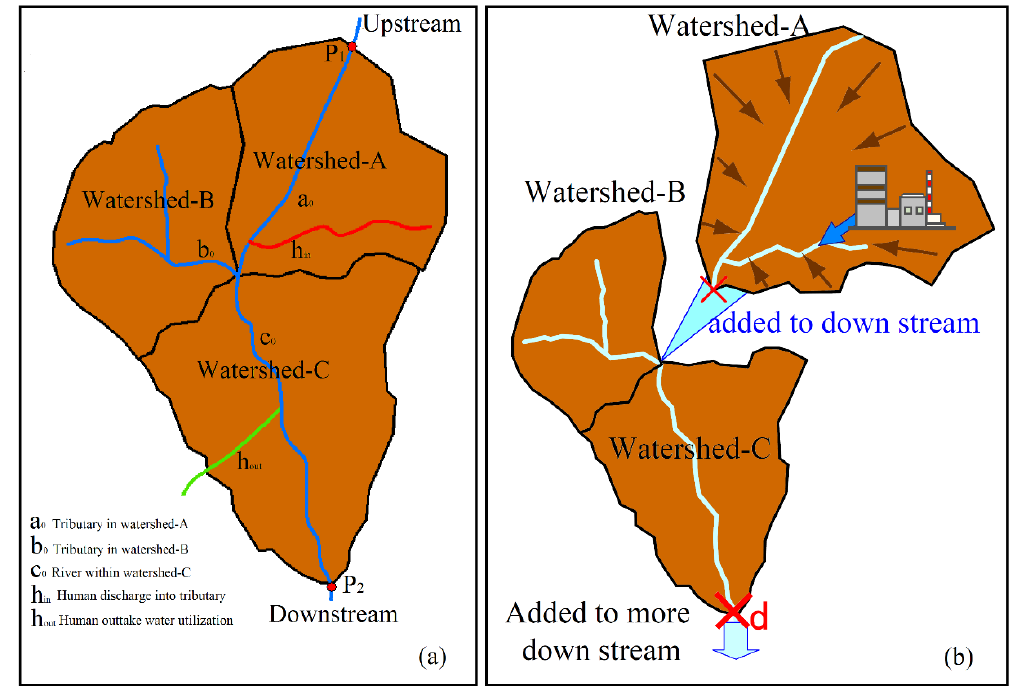
Figure 3. Schematic diagram of water flows and heavy metal accumulation in the river system: ( a ) Distribution of river system; ( b ) Heavy metal accumulations from upstream to downstream.